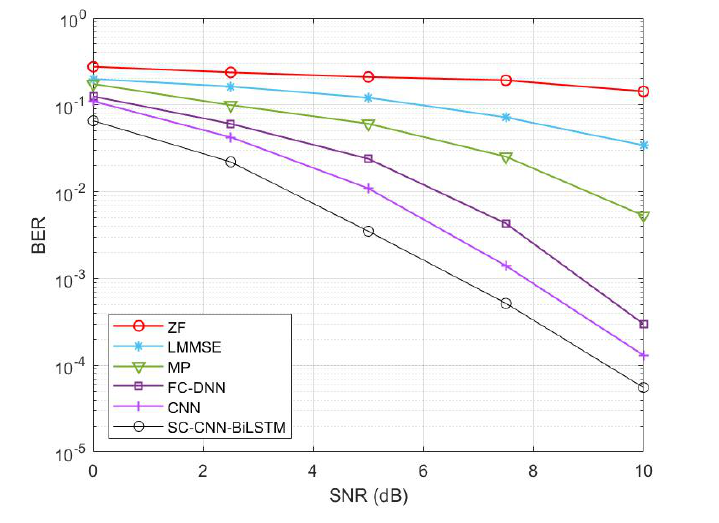
Figure 6. BER performance comparison for simulation